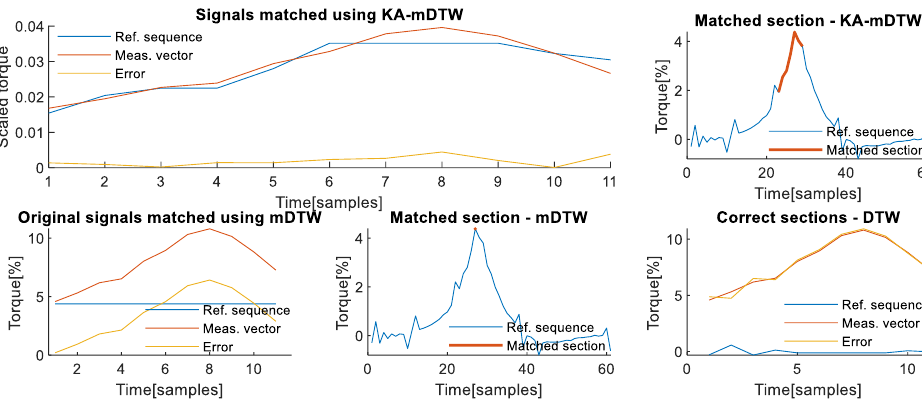
Figure 9. Matching of chosen signals from the 1st axis. ( Upper left ) Graph shows optimally matched section of the reference sequence and the entire measurement vector as well as the sample-wise matching error. ( Upper right ) Reference sequence profile with the highlighted section, which was optimally matched with the measurement vector. The highlighted section correctly interprets the phase of the contact task contained in the measurement vector. ( Lower left ) Section of reference sequence matched with measurement vector using mDTW without scaling the signals. A matching error has the same shape as the measurement vector, since the entire vector was only matched with a single point of reference, which was closest in value. ( Lower middle ) Reference sequence profile with the highlighted section, which is just a point matched with the measurement vector using mDTW. The highlighted section corresponds to the peak of the reference signal, since it was the closest to all the values within the measurement vector. ( Lower right ) The section of the reference sequence, which was optimally matched using KA-mDTW from the upper right graph, is matched with the measurement vector using DTW algorithm to determine a realistic matching error.